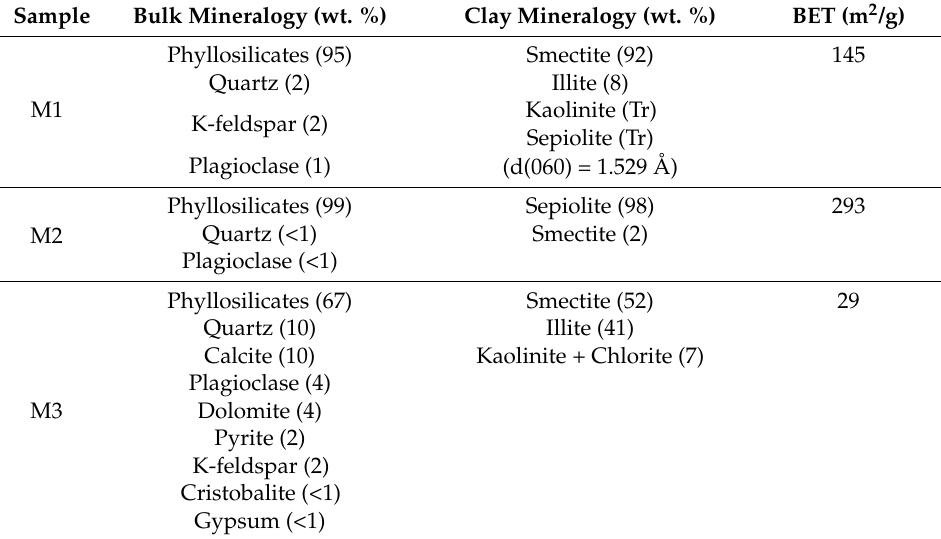
Table 1. The mineralogical composition and BET specific surface areas.